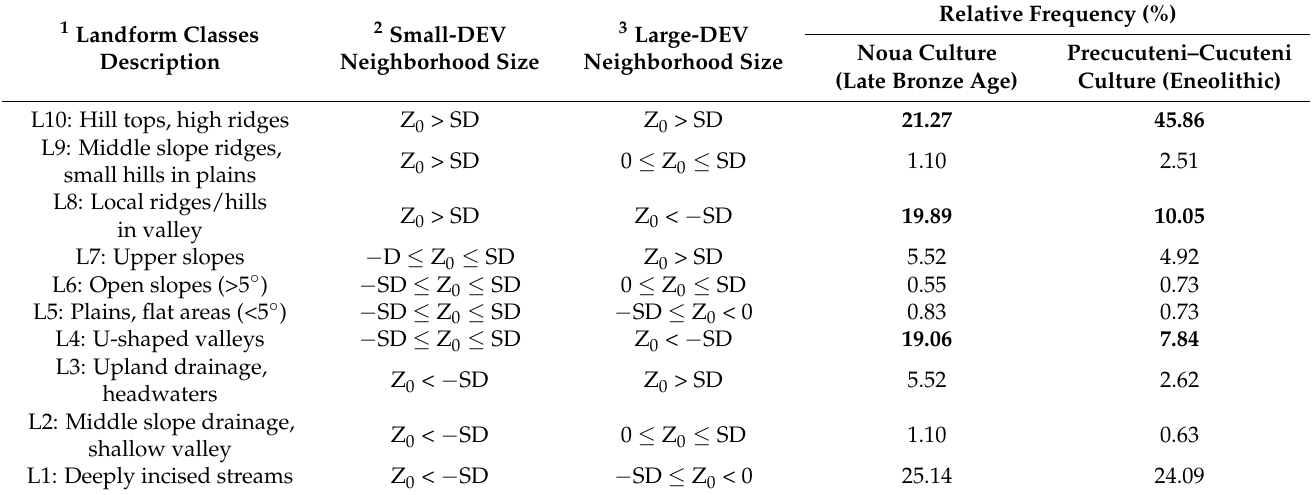
Table 5. Differences in habitation practices characteristics between Noua Culture (Late Bronze Age) and Precucuteni–Cucuteni Culture (Chalcolithic) [25] highlighted by the archaeological sites occurring over ten specific landform classes in the Jijia catchment (see Figure 6); the main differences are underlined in bold.